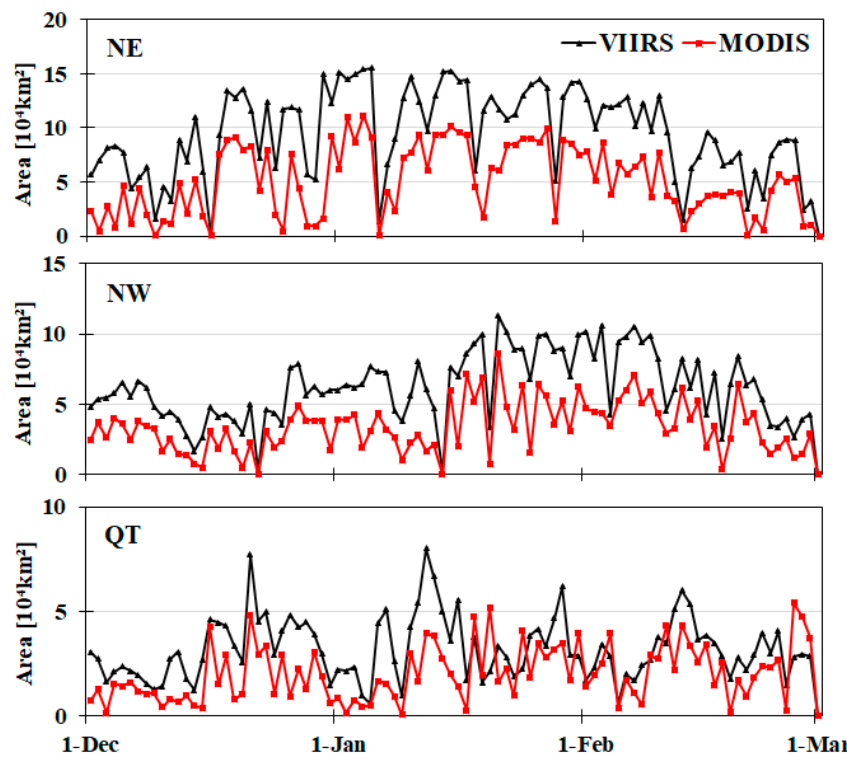
Figure 3. SCA with respect to VIIRS and MODIS in the snow season (1 December 2019 to 29 February 2020). The NE, NW and QT test regions are shown from top to bottom, respectively.